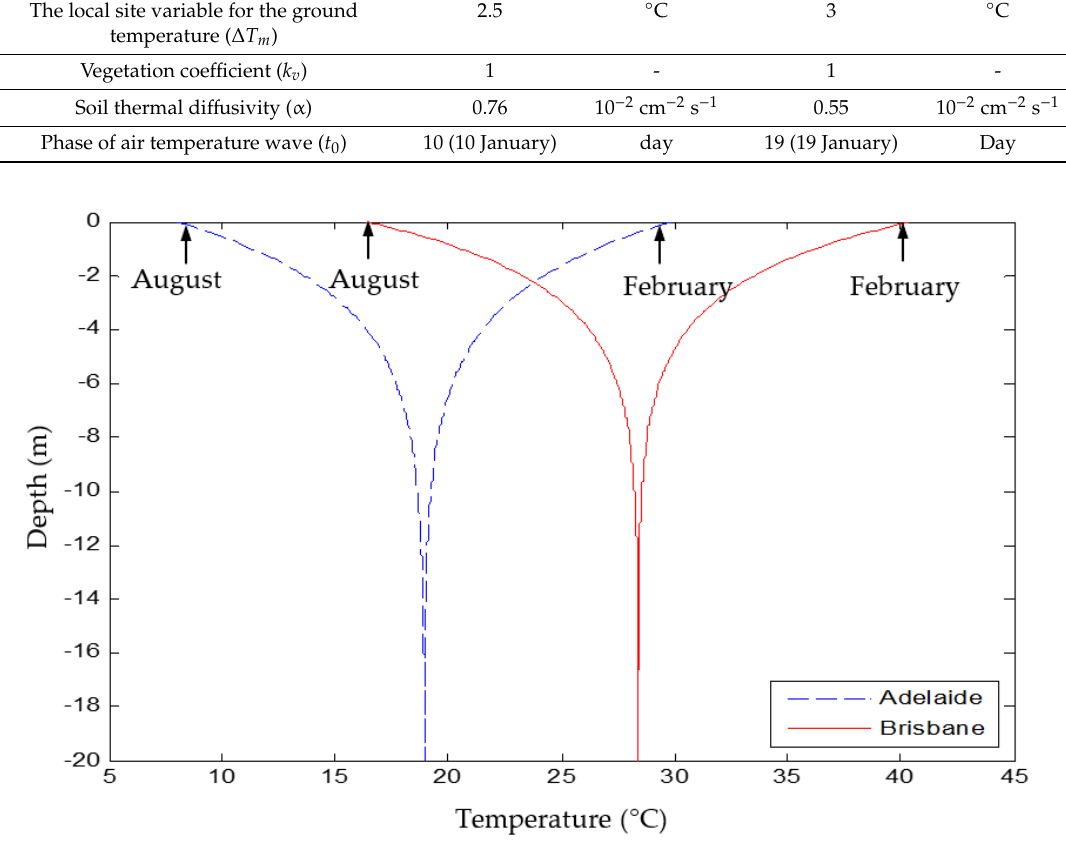
Figure 5. Typical soil temperature in Adelaide and Brisbane.